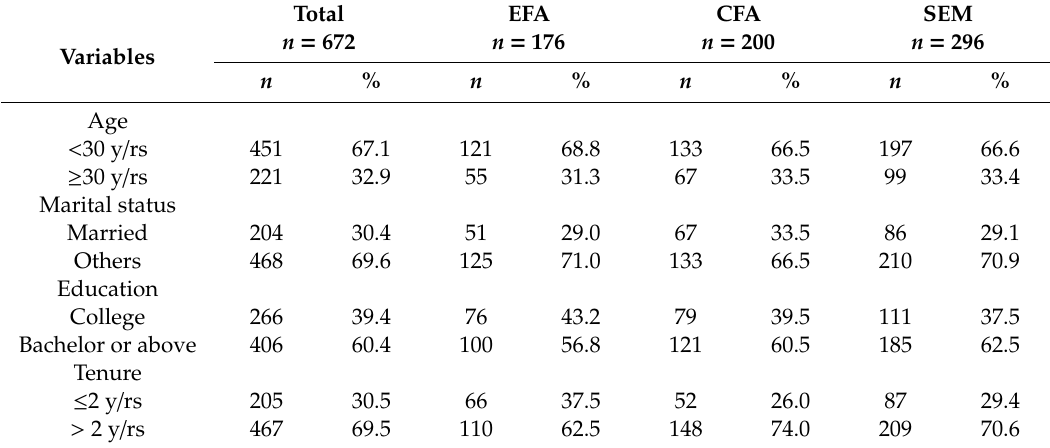
Table 1. Demographic Characteristics of the Questionnaire